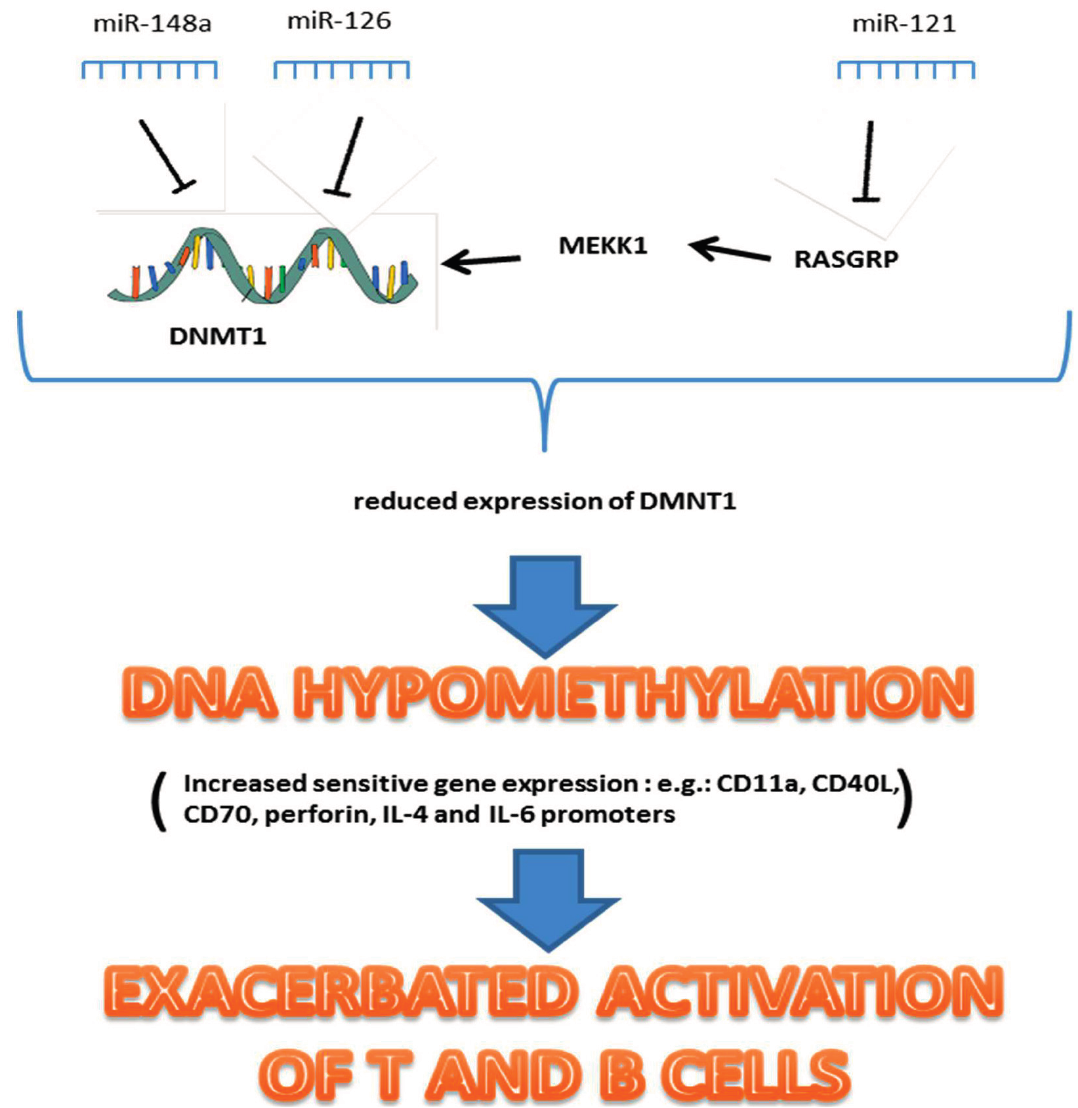
Figure 1. MiRNA involved in epigenetic deregulation in